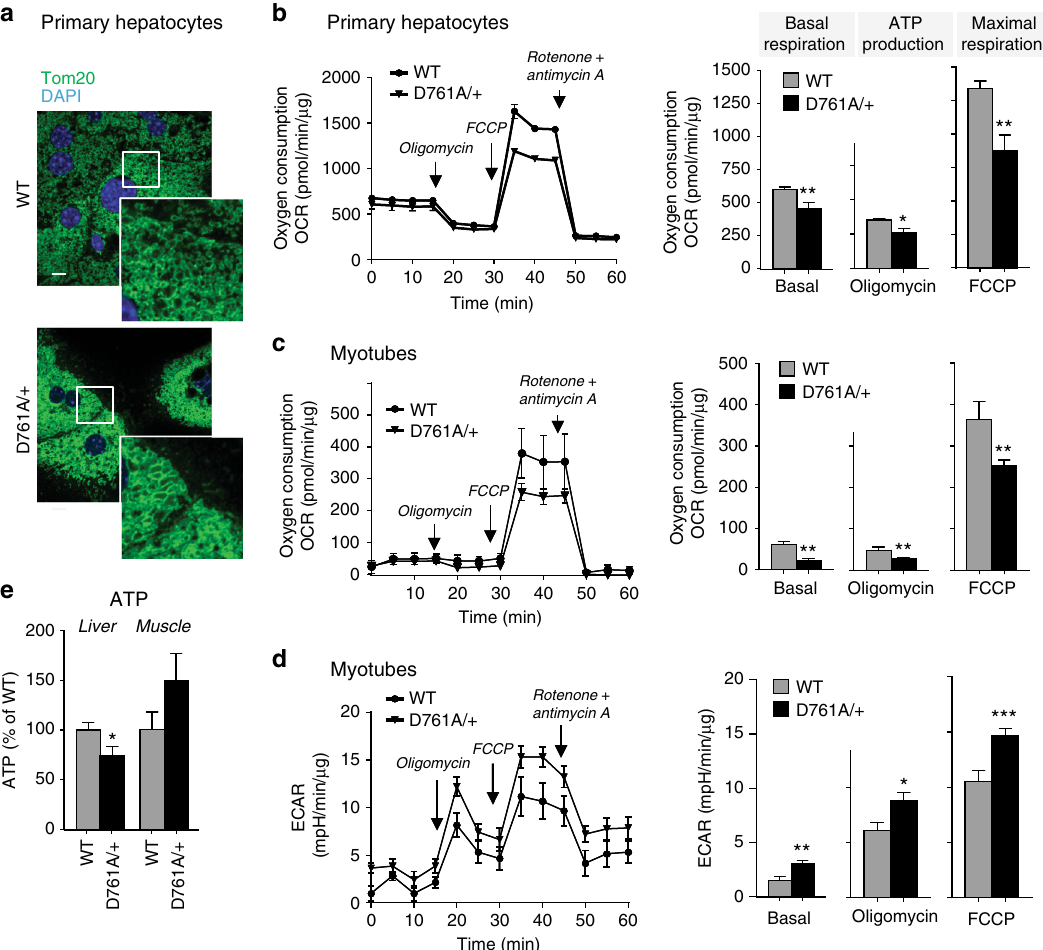
Fig. 6 Impact of Vps34 inactivation on mitochondrial content and function. a Confocal images of Tom20 staining (mitochondrial marker) in primary hepatocytes in insulin-free HM media. DAPI-stained nuclei are shown in blue. A representative image of 50 cells analyzed is shown. Scale bar, 20 µ m. b , c Seahorse XF24 measurement of oxygen consumption (OCR) by hepatocytes or differentiated myotubes isolated from WT and Vps34 D761A/+ mice. Quanti fi cation of basal respiration, ATP production and maximal respiratory capacity are shown on the graphs. Hepatocyte cultures derived from 3 – 5 independent mice/genotype; myotube cultures derived from three independent mice/genotype. Data represent mean ± SEM (Student t -test). d Seahorse XF24 measurement of extracellular acidi fi cation rate (ECAR) of differentiated myotubes. Myotube cultures were derived from three independent mice/ genotype. e Total ATP levels in liver and gastrocnemius muscle in randomly fed mice. Data represent mean ± SEM (non-parametric Mann – Whitney t -test). 5 mice/genotype. * p < 0.05, ** p ≤ 0.01, *** p ≤